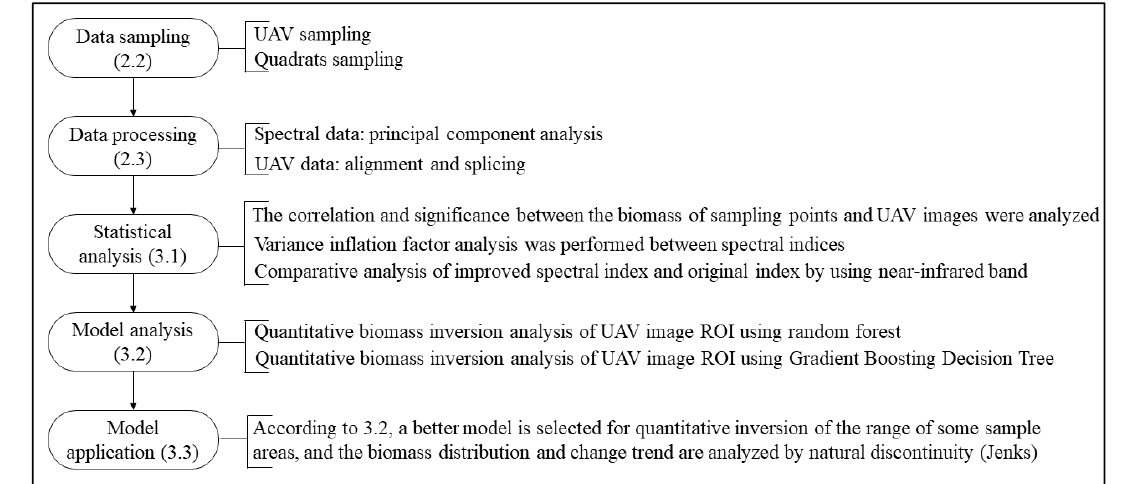
Figure 1. Methodological scheme. The figures in () are the corresponding chapters in this paper.